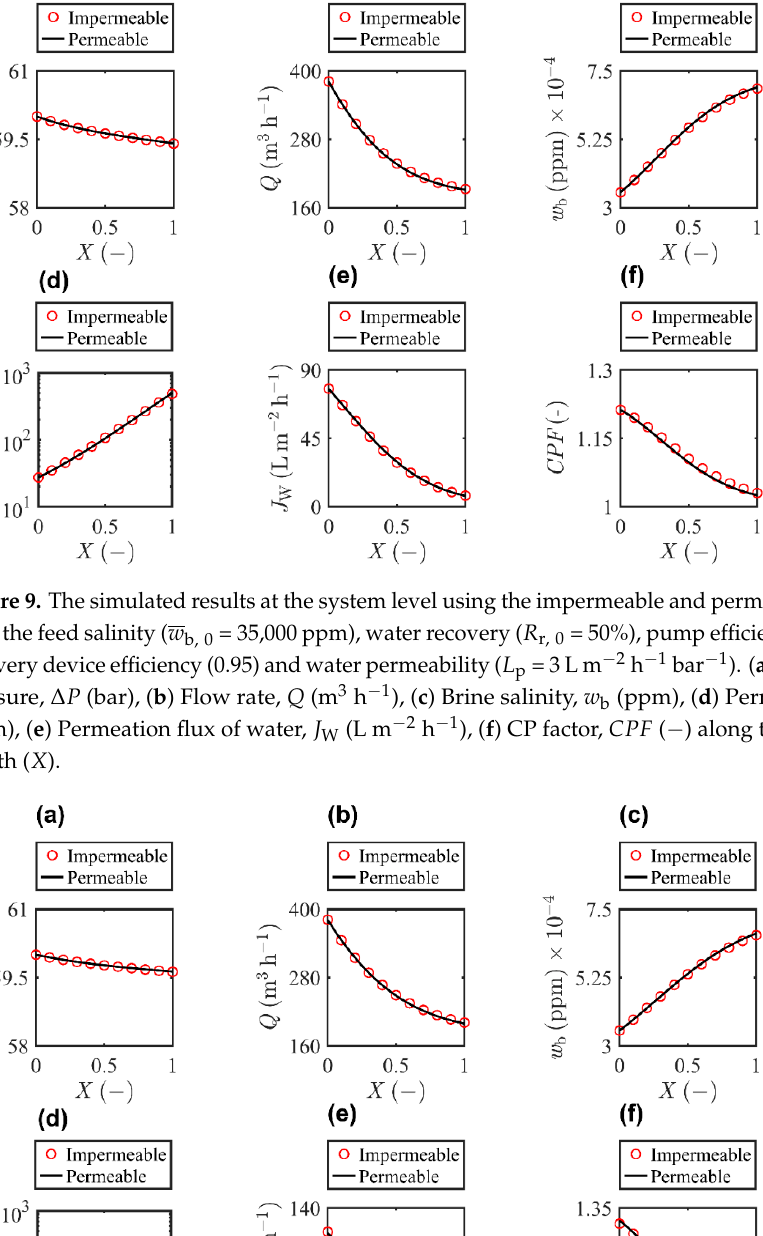
mensionless length ( X ).